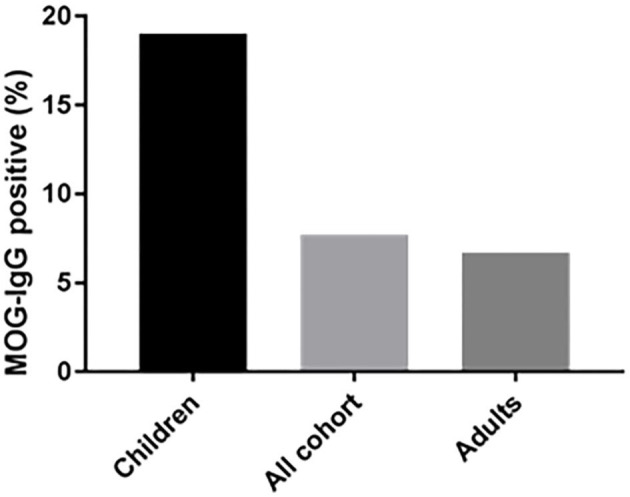
The seroprevalence of MOG-abs is age-dependent. The mean percentages of MOG-abs-positive patients are shown for each subpopulation.